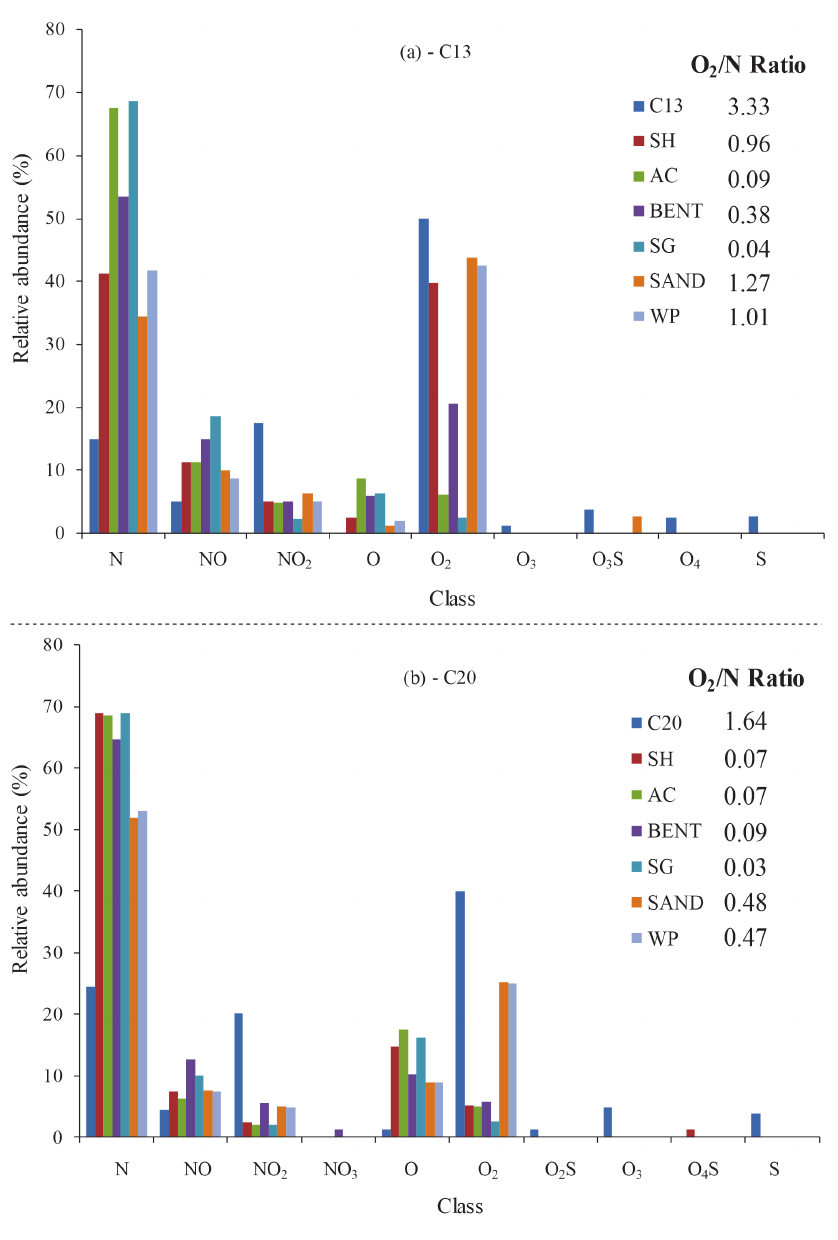
Figure 3. Heteroatom classes distribution from the ESI (-) FT- ICR MS data for the (a) crude oil C13 and filtered oils; (b) crude oil C20 and filtered oils. Note: SH= shale, AC= activated carbon; BENT= bentonite, SG= silica gel; SAND= sandstone; WP= wood